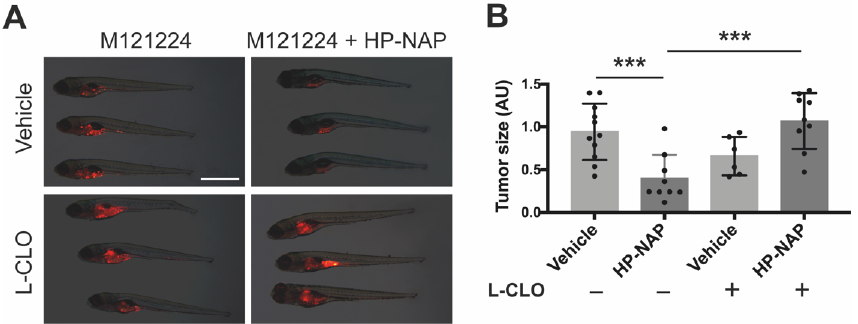
Figure 6 . The anti ‐ tumor activity of HP ‐ NAP is strictly dependent on macrophages: effect of macrophage depletion by liposome ‐ encapsulated clodronate (L ‐ CLO). Tg(mpeg1:EGFP)gl22 zebrafish embryos were xenotransplanted with M121224 melanoma cells (red) and treated with empty liposomes + saline (vehicle), or empty liposomes + HP ‐ NAP, L ‐ CLO + saline (L ‐ CLO) or L ‐ CLO + HP ‐ NAP at 2 dpi and observed at 4 dpi. ( A ) Representative fluorescence stereoscope images of the total tumor mass in fishes at 4 dpi. Scale bar: 1 mm. ( B ) Scatter plots show the quantification of the total tumor size (AU: Arbitrary Unit) at 4 dpi. Values are expressed as mean ± SEM and analyzed by one ‐ way ANOVA; ***, p < 0.001, HP ‐ NAP ( n = 9) vs. vehicle ( n = 11) and L ‐ CLO + HP ‐ NAP ( n = 9) vs. HP ‐ NAP ( n = 11).